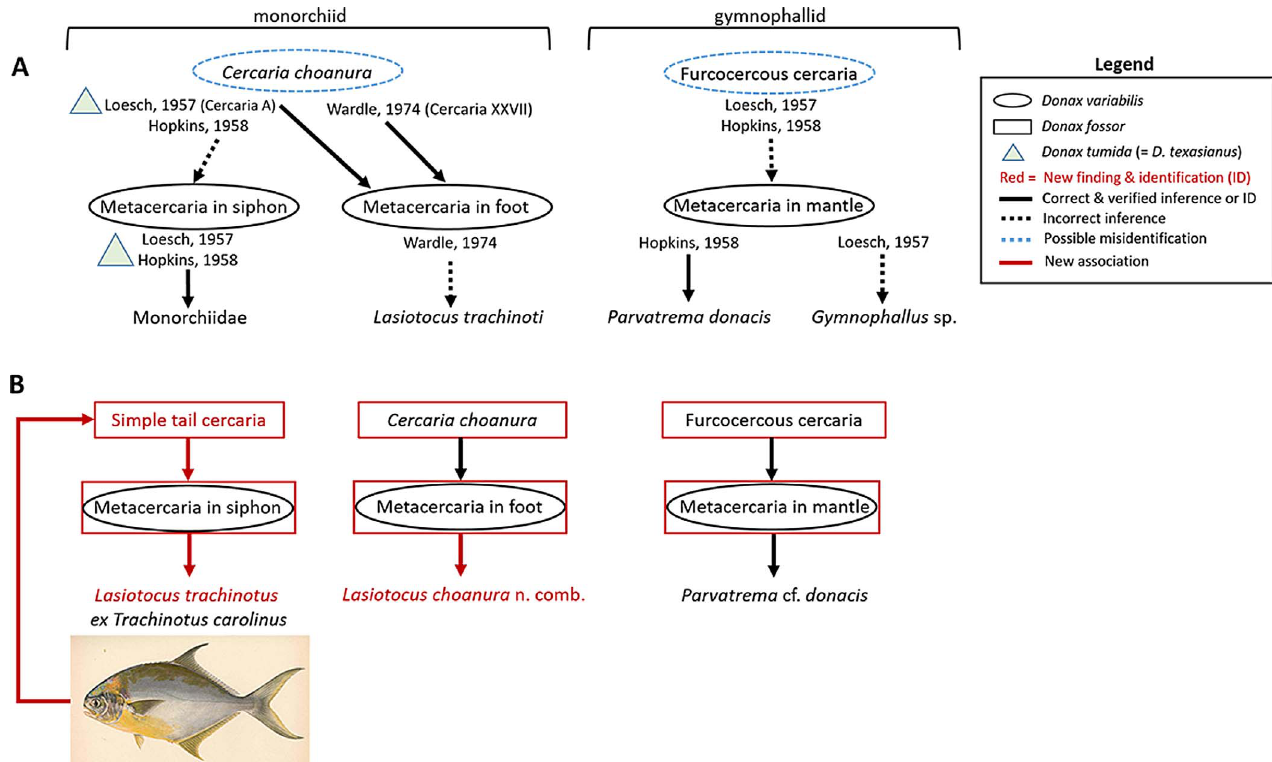
Figure 3. Summary of fi ndings by authors who observed monorchiid (a) and gymnophallid (b) life stages in coquina Donax variabilis, barring Cercaria pocillator and Cercaria fragosa , which we did not encounter and were only speculated to encyst in D. variabilis by Holliman [29]. (A) previous studies; (B) Current study showing that both Donax fossor and D. variabilis may act as second intermediate host, but D. fossor is the sole fi rst intermediate host on the Atlantic coast. The fi sh image was provided by the Freshwater and Marine Image Bank https:// digitalcollections.lib.washington.edu/digital/collection/ fi shimages/search